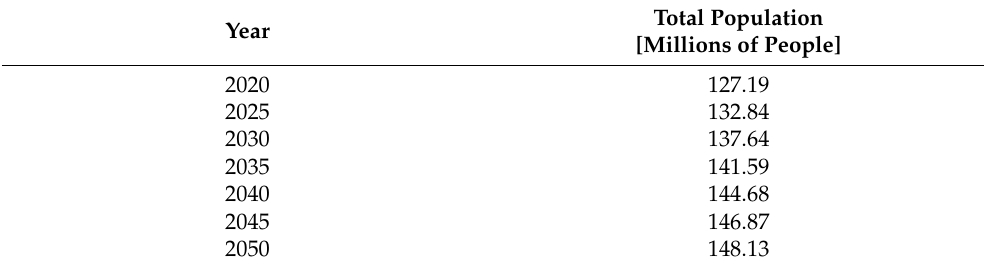
Table 2. Mid-year population projections for Mexico. Source: [26].